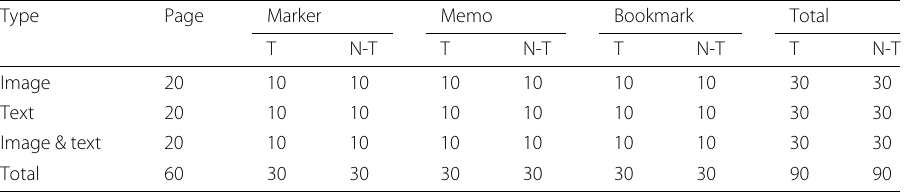
Table 1 Type of page content and distribution of learning